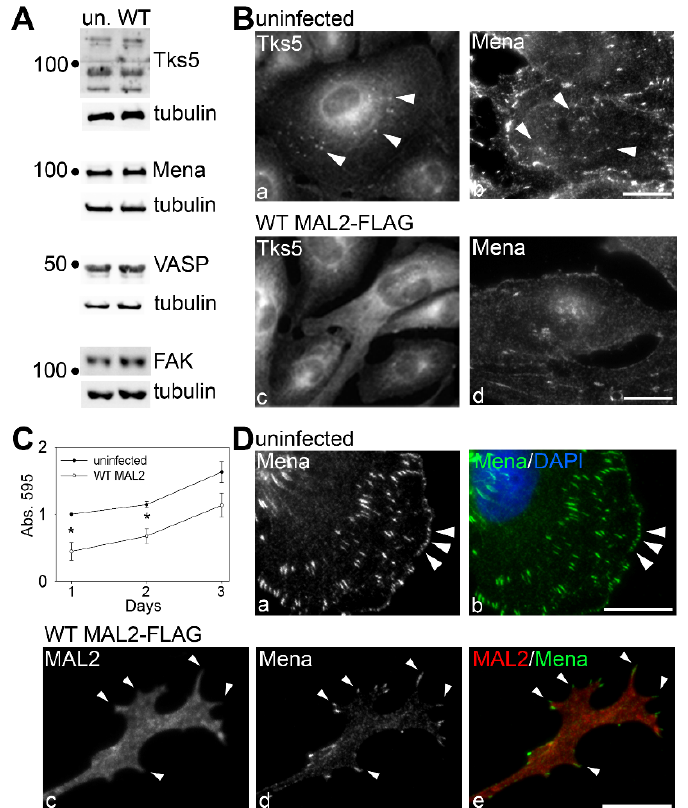
Figure 7. MAL2 overexpression disrupts invadopodia formation. ( A ) Lysates from uninfected Clone 9 cells and Clone 9 cells expressing wild type (WT) MAL2 were immunoblotted for Tks5, Mena, VASP, FAK and tubulin (as a loading control) as indicated. Molecular weight standards are indicated on the left in kDa. ( B ) Uninfected Clone 9 cells and Clone 9 cells expressing wild type MAL2 were immunolabeled for Tks5 or Mena as indicated. Arrowheads in panels a and b mark Tks5 and Mena present in juxta-nuclear invadopodia that are absent in cells expressing MAL2. ( C ) Uninfected and MAL2-expressing cells were seeded onto 96-well plates at 4000 cells / well and relative cell numbers monitored after 1 ( p ≤ 0.006), 2 ( p ≤ 0.006) or 3 days. Values represent the mean ± SEM from at least three independent experiments each performed in triplicate. ( D ) Uninfected Clone 9 cells were labeled for Mena. Arrowheads mark Mena present at the surface in patches. ( E ) Clone 9 cells expressing wild type MAL2 were immunolabeled for Mena and MAL2 as indicated. Arrowheads mark Mena present at the far distal tips of protrusions induced by MAL2 expression. Bar = 10 µm.